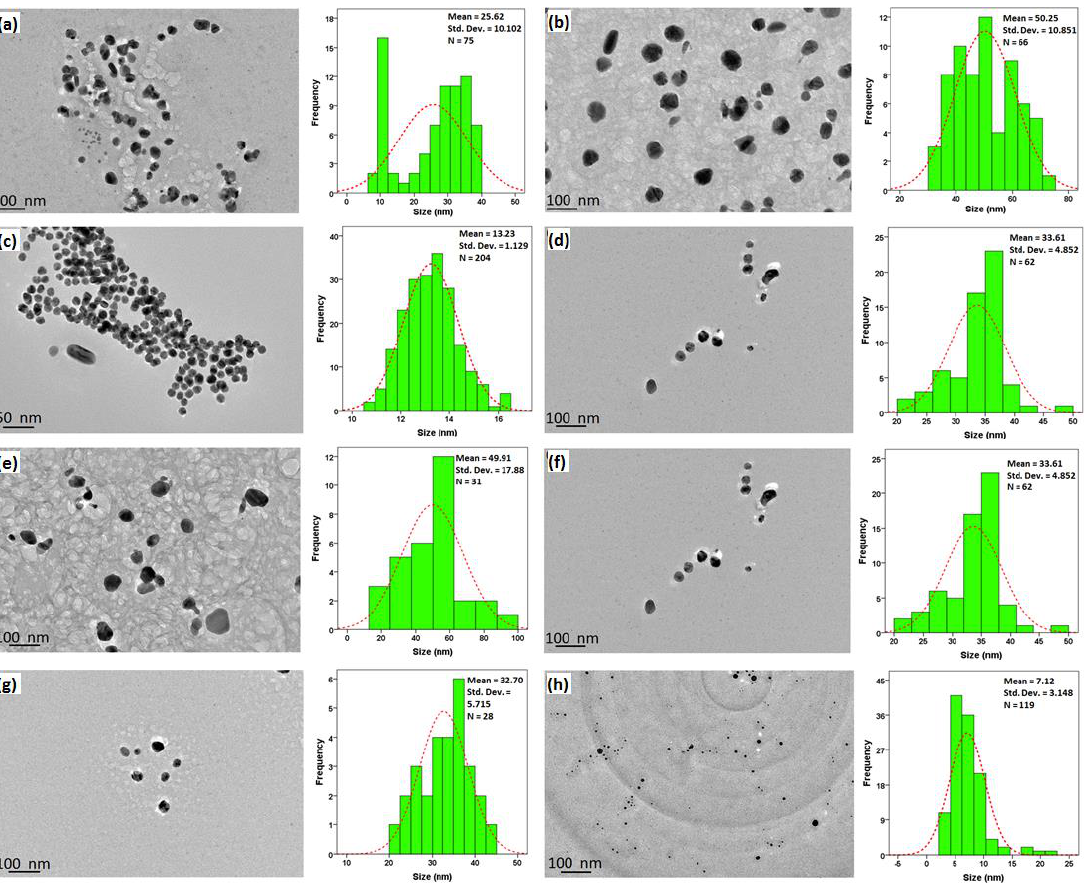
Figure 3. TEM of AgNPs synthesized by various parameters: amount of peel powder, ( a ) 0.2 g, ( b ) 0.5 g; concentration of AgNO 3 , ( c ) 2 mM, ( d ) 7.5 mM; temperature: ( e ) 27 °C, ( f ) 45 °C; and pH ( g ) pH 4 ( h ) pH 7.